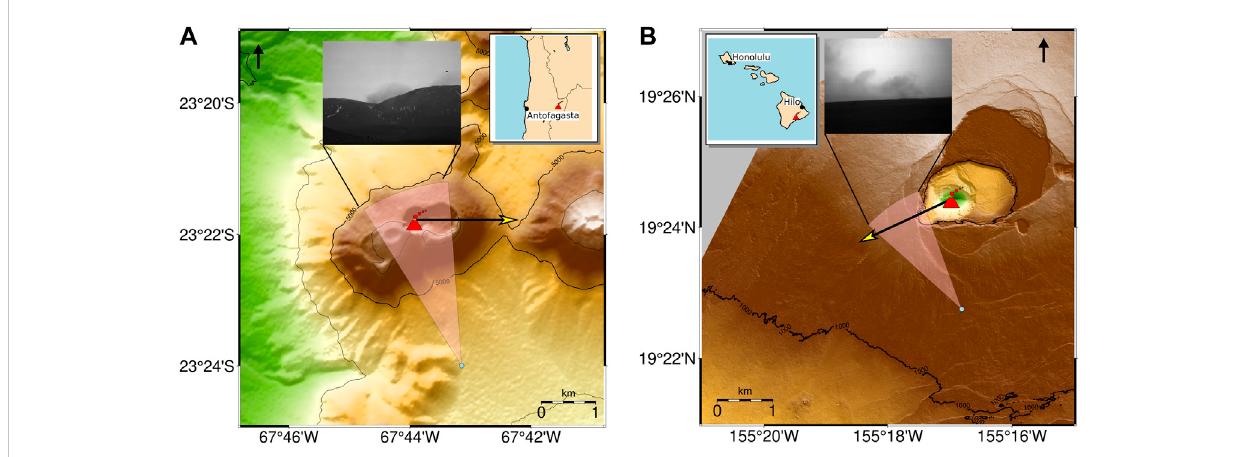
FIGURE 2 Digital elevation models (DEMs) of site locations with cameras shown as blue dots and their fi eld of views extending from them, along with an example image from the on-band camera in each case. Red symbols indicate gas source locations. Typical plume motions are shown by yellow-headed arrows, but can vary signi fi cantly throughout the year. (A) Lascar (DEM from SRTM data); (B) K ī lauea (DEM from LiDAR data taken from Mosbrucker et al.,